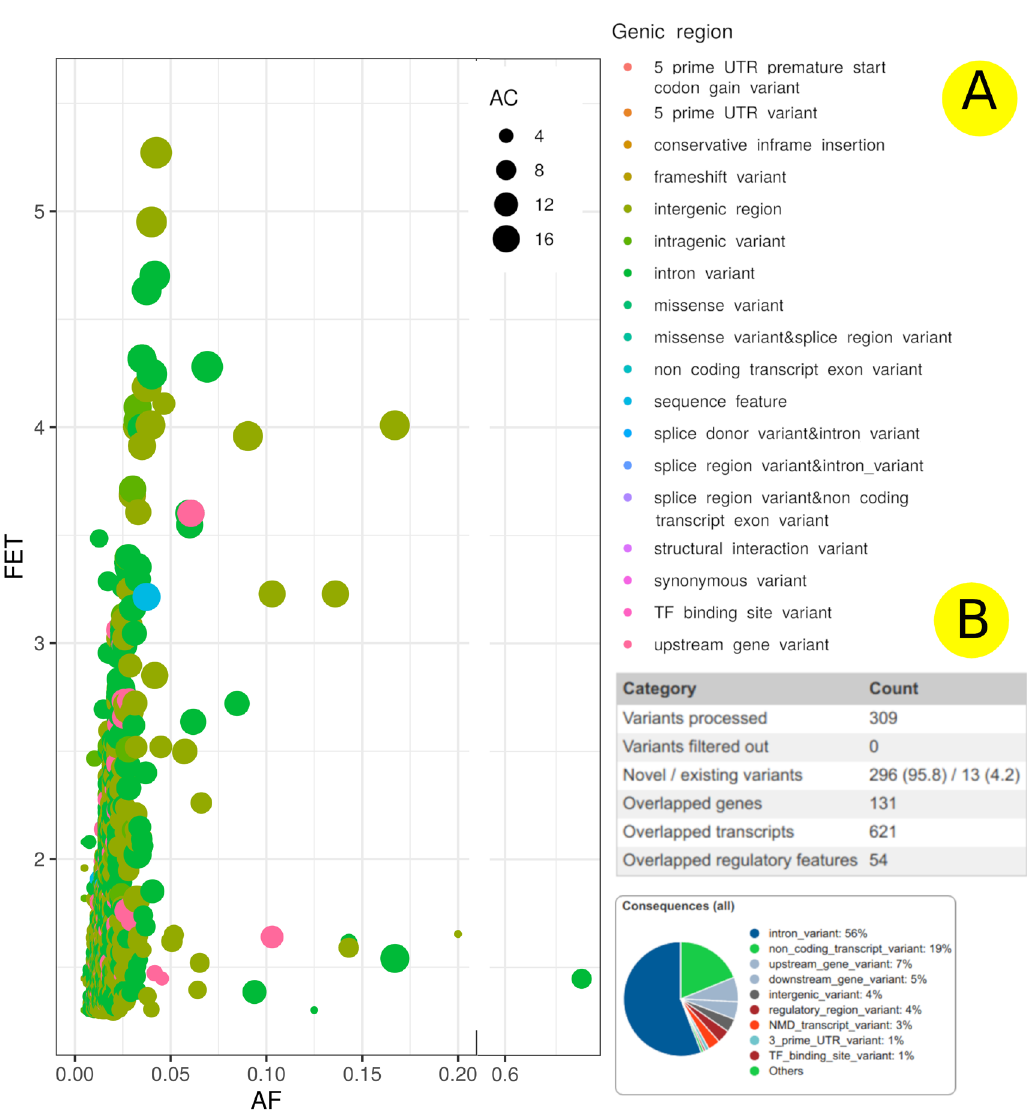
Figure 5. The genic structure of SNPs associated with EH. ( A ) The allele frequency vs. FET scores -log10 of the studied SNP variants. Allele frequency of SNP variants ( x -axis) vs. FET scores -log10 ( y -axis), the SNP genic region (color) and the maximum allele count in studied population (size). ( B ) The percentage of SNPs distribution across gene structure.